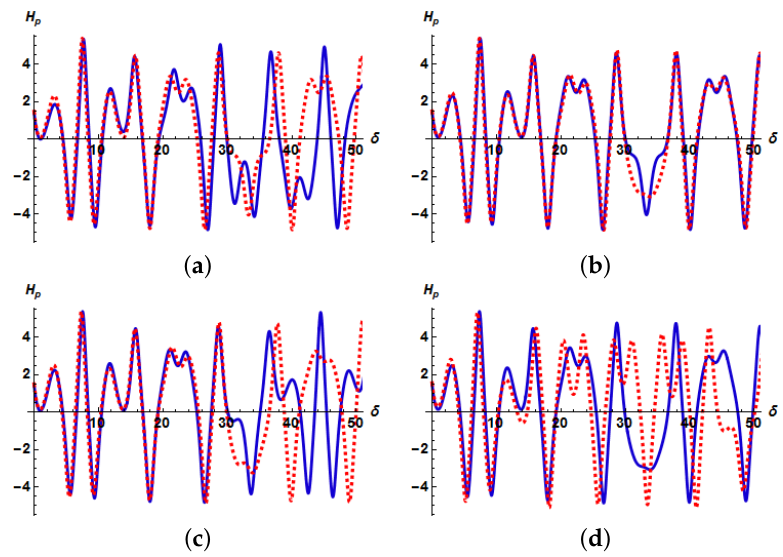
Figure 13. Sensitivity plots for the dynamical system with different initial